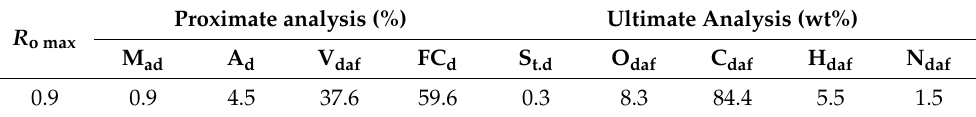
Table 1. Ultimate and proximate analysis results of the raw coal sample. Proximate analysis (%) Ultimate Analysis R o max